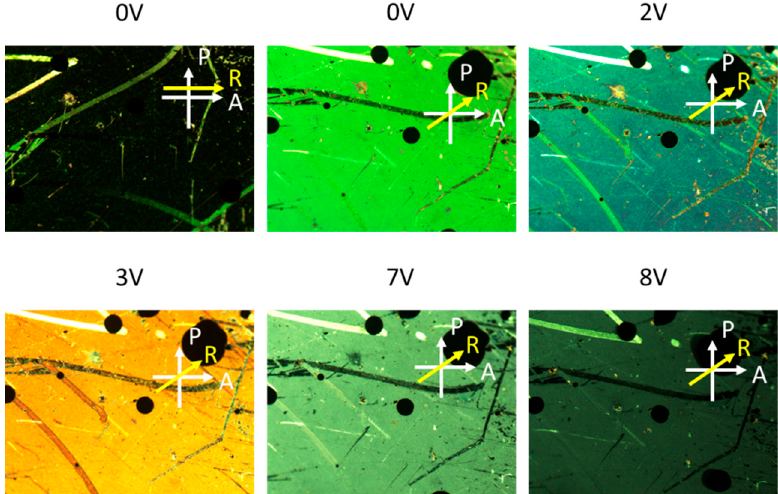
Figure 3. Optical textures of tunable liquid crystal (LC)/gold nanoisland film (Au NIF) with various applied voltages under crossed polarizers. White arrows indicate the transmission axes of the polarizer and analyzer, while the yellow arrow indicates the rubbing direction.